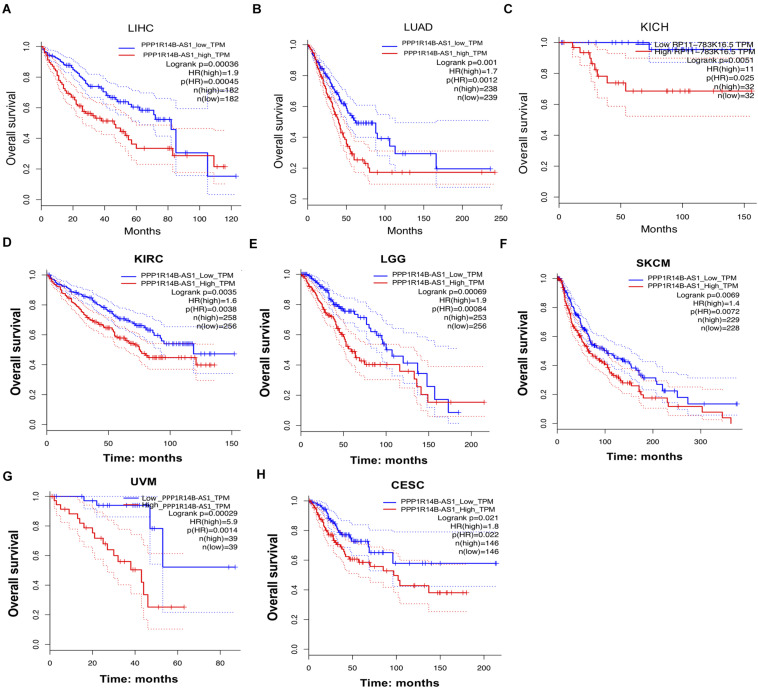
PPP1R14B-AS1 upregulation was related to poor survival in several cancers. (A) Patients with LIHC were divide into two groups in accordance with the median of the expression value of PPP1R14B-AS1 (PPP1R14B-AS1_low and PPP1R14B-AS1_high), and then Kaplan–Meier survival curves were constructed to analyze the overall survival (OS) of the two groups by GEPIA gene analysis tool (http://gepia.cancer-pku.cn/detail.php?gene=&clicktag=survival). Hazards Ratio (HR) was calculated based on Cox PH Model. (B–H) Patients with LUAD, KICH, KIRC, LGG, SKCM, UVM, or CESC were divided into the PPP1R14B-AS1_low and PPP1R14BA-AS1_high groups according to the median value of PPP1R14B-AS1 expression, respectively, and then Kaplan–Meier survival curves were constructed to analyze the OS of the two groups by using the GEPIA gene analysis tool. Data were analyzed through the log-rank test.